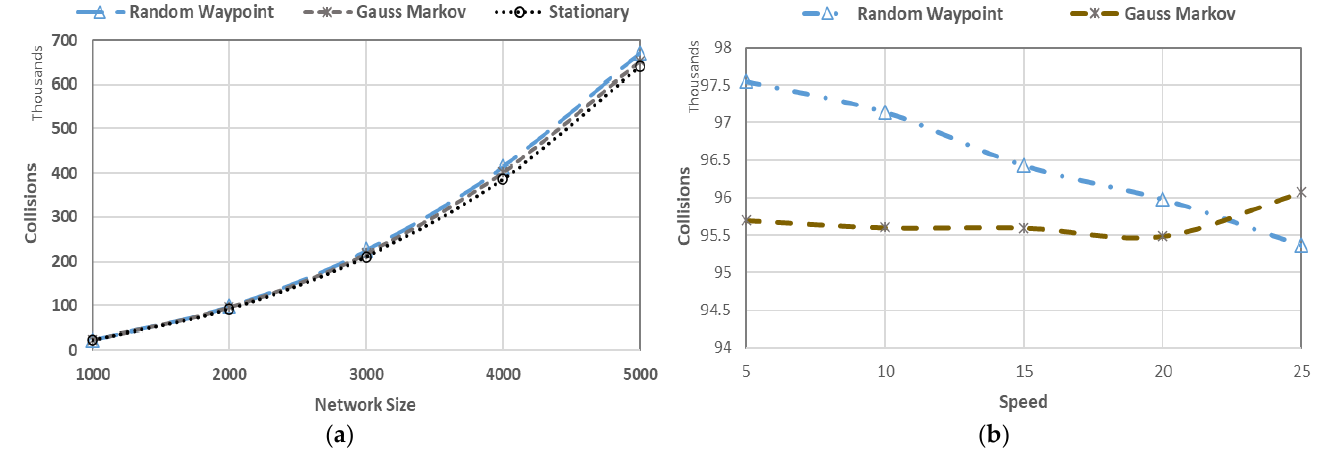
Figure 5. Traffic collisions: ( a ) collisions for a network with 2000 × 2000 area, 20 B payload, and 5 m/s speed; ( b ) collisions for a network with 2000 × 2000 area, 2000 devices, and 60 B payload across different speeds in m/s.